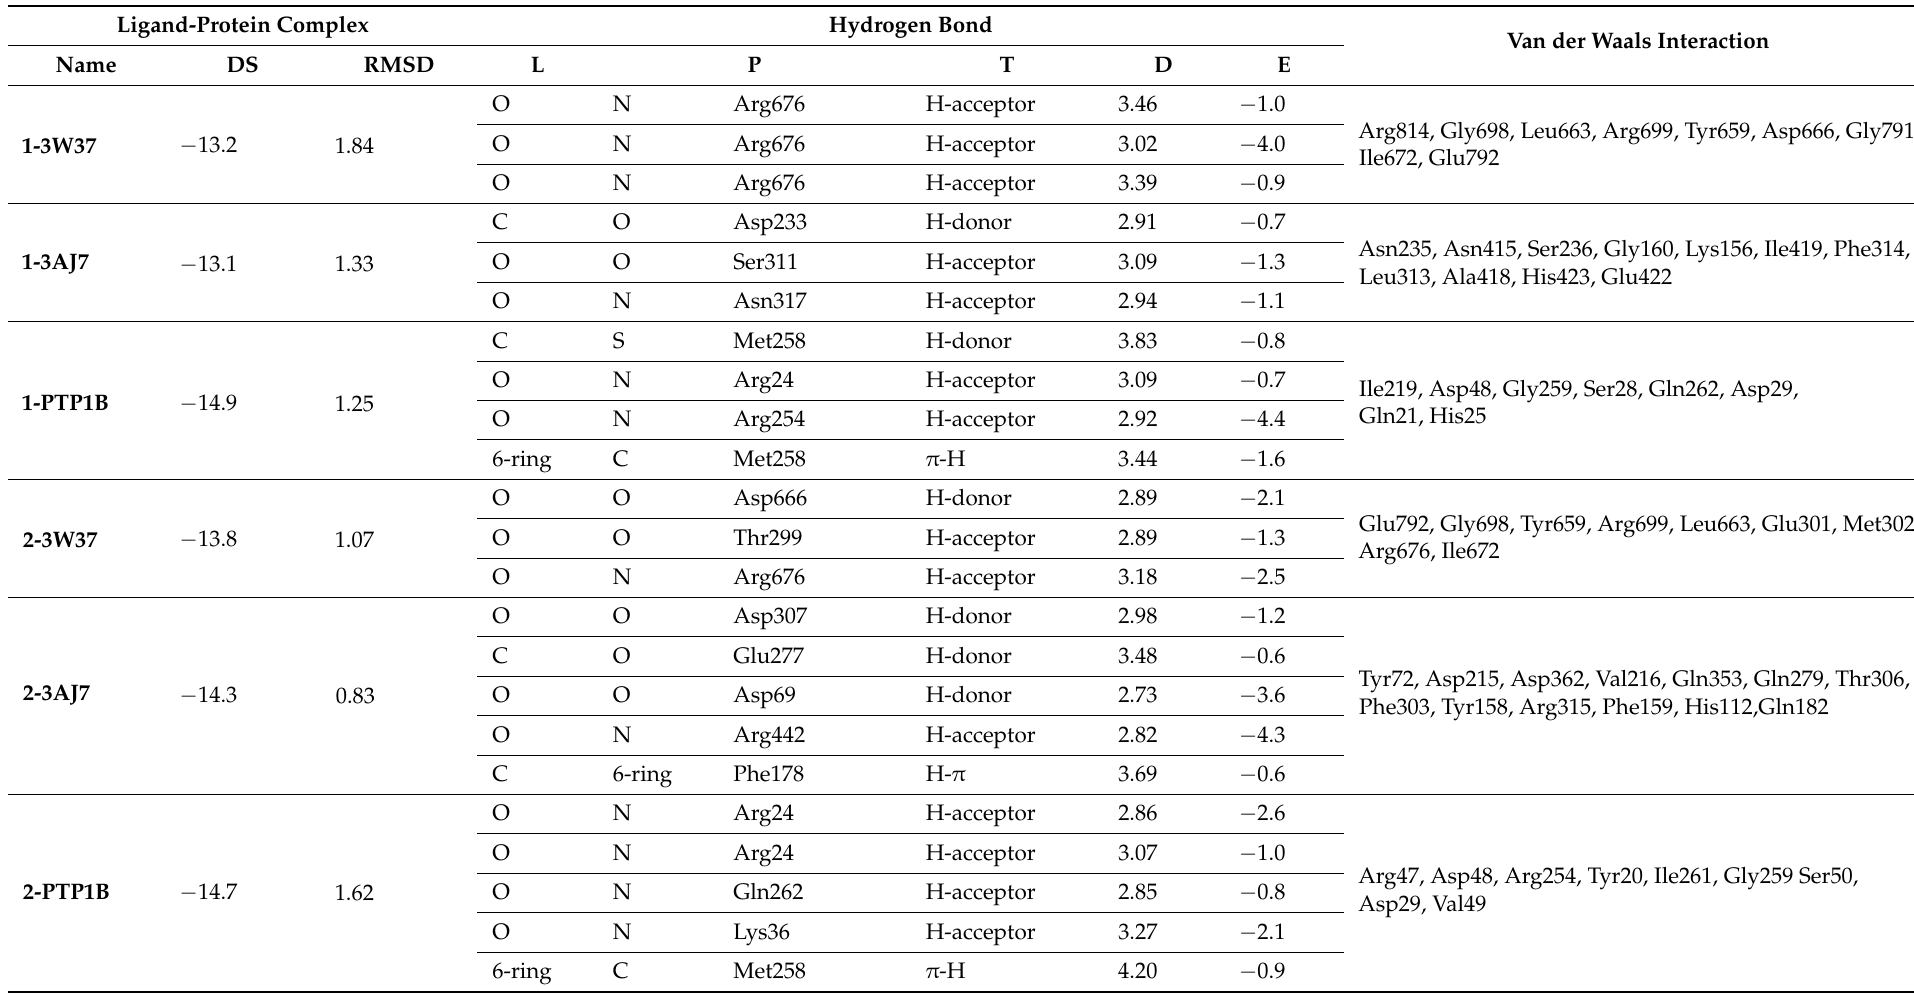
Table 5. Molecular docking simulation results for inhibitory complexes between the ligands (compounds 1 and 2 ) and the targeted proteins (3W37, 3AJ7, and PTP1B): 1-3W37 , 1-3AJ7 , 1-PTP1B , 2-3W37 , 2-3AJ7 , and 2-PTP1B . Ligand-Protein